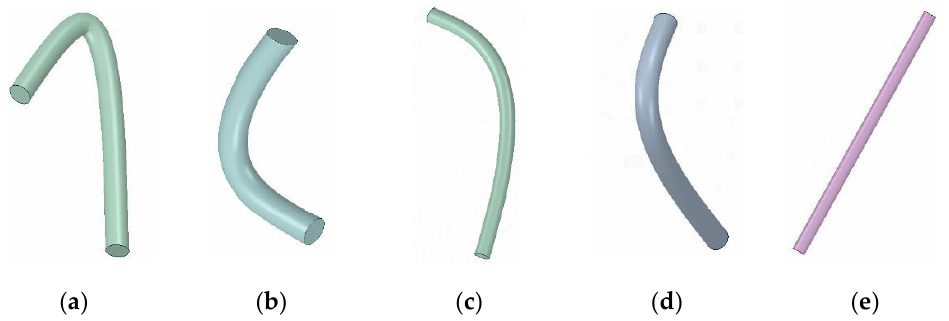
Figure 6. Bending angles of different carbon nanotube models: ( a ) 30 degree angle; ( b ) 60 degree angle; ( c ) 100 degree angle; ( d ) 140 degree angle; ( e ) 180 degree angle.